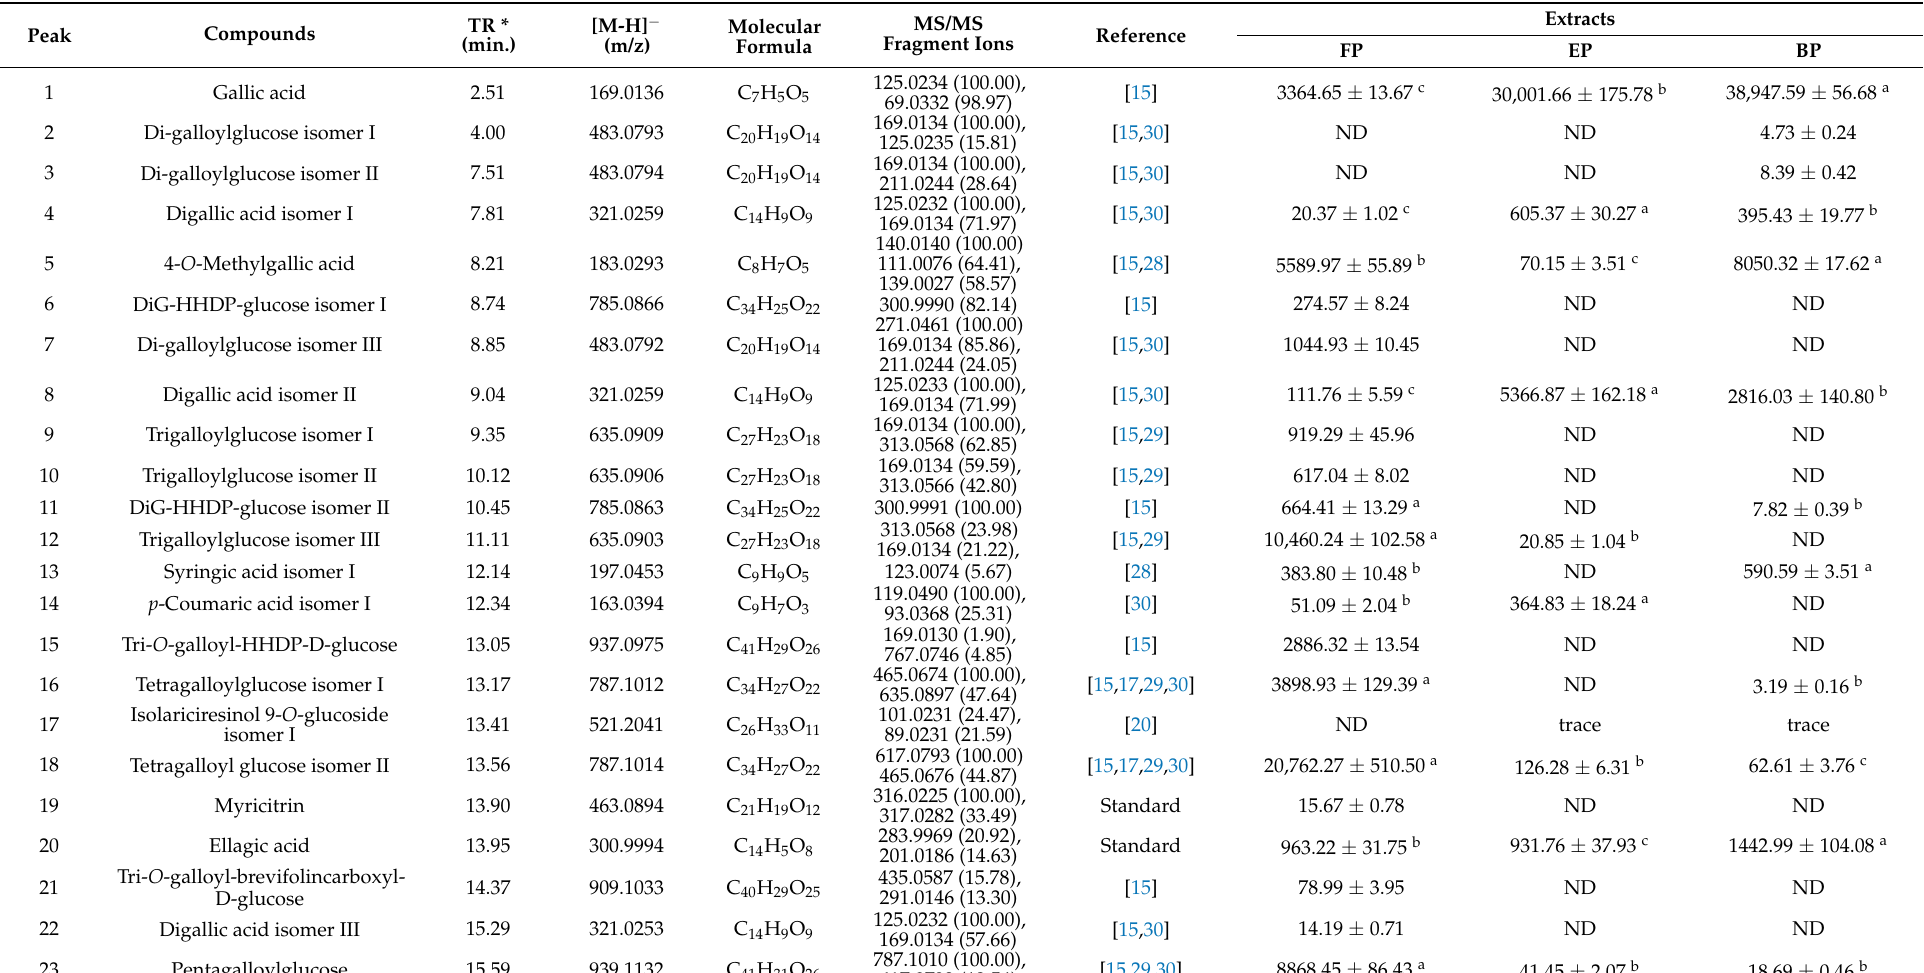
Table 1. The identified phenolic compounds, total phenolics and total flavonoids in the free, esterified and insoluble-bound phenolic fractions from water caltrop ( Trapa quadrispinosa Roxb.)